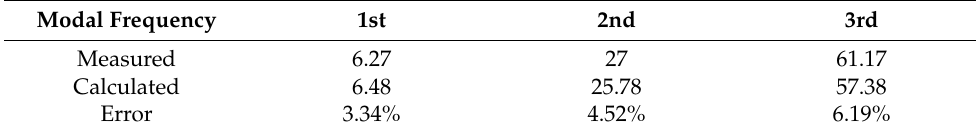
Table 9. Calculated and measured natural frequencies of the test beam